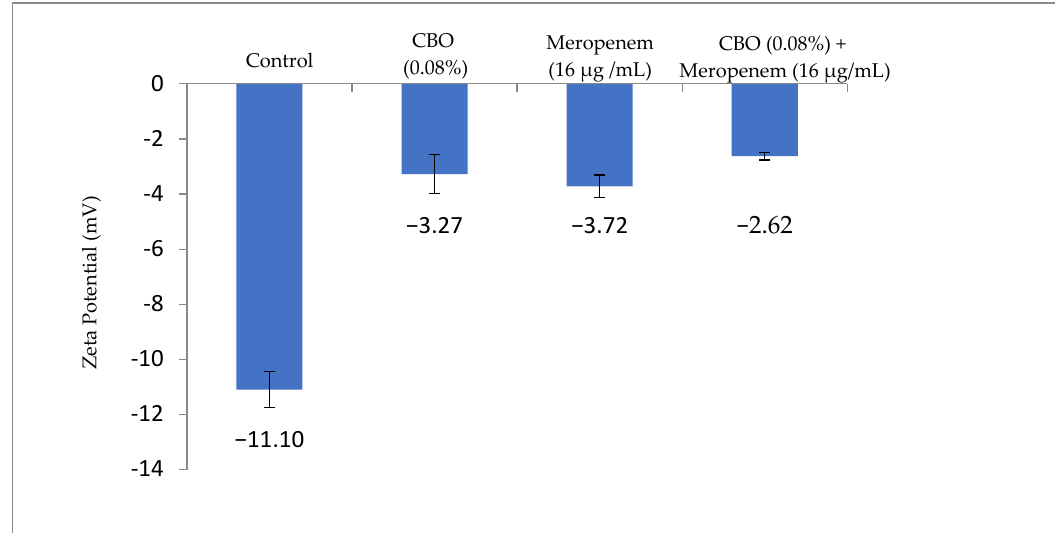
Figure 3. Zeta potential value (mV) of K. pneumoniae BAA-1705 treated with CBO and meropenem, alone and in combination.